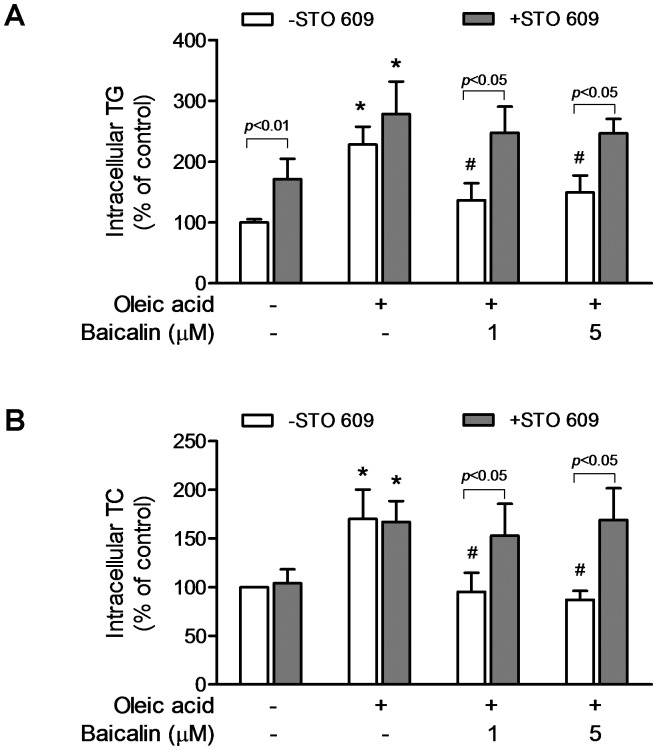
Inhibition of CaMKKβ prevents baicalin-induced reduction in intracellular lipid accumulation in HeLa cells caused by oleic acid.Cells were treated with 1 and 5 µM baicalin in the presence of 0.4 mM oleic acid for 24 hr without (open bars) or with pre-incubated with 10 µg/mL STO-609 (solid bars). The control cells were incubated with 1.76% bovine serum albumin (BSA) for 24 h. Intracellular triglyceride (TG, A) and intracellular cholesterol (TC, B) were measured as described in Material and Methods. The histogram represents the mean of the percentage of the vehicle control ± SE from at least three independent experiments. * p<0.05 compared to BSA control; #
p<0.05 compared to untreated oleic acid control.